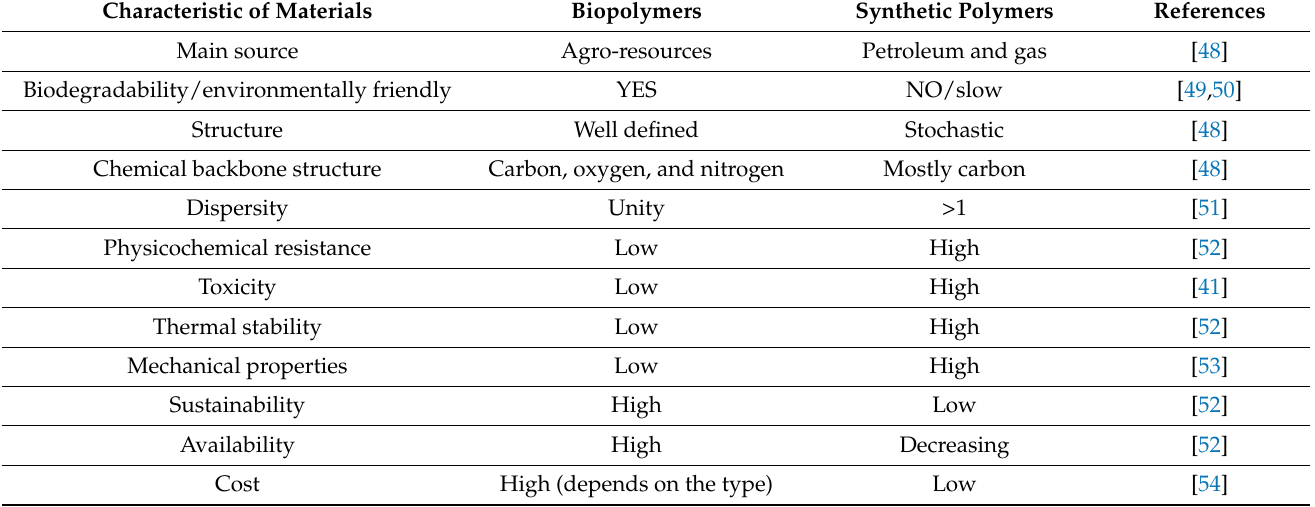
Table 1. Characteristics of biopolymers vs. synthetic